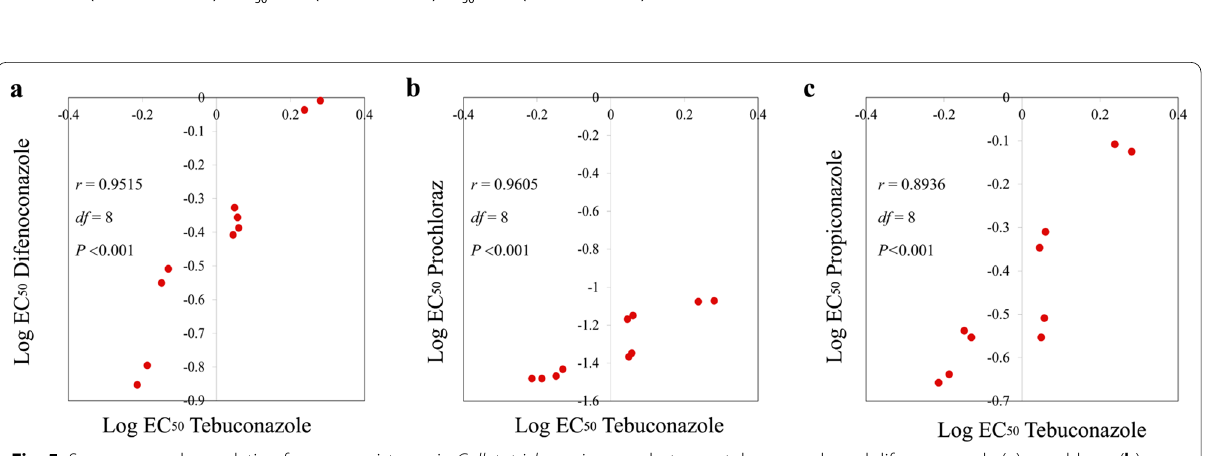
Fig. 5 Spearman rank correlation for cross resistance in Colletotrichum siamense between tebuconazole and difenoconazole ( a ), prochloraz ( b ), or propiconazole ( c ). The points represent the log EC 50 values (logarithmic of EC 50 ) among the tested isolates for the indicated fungicide